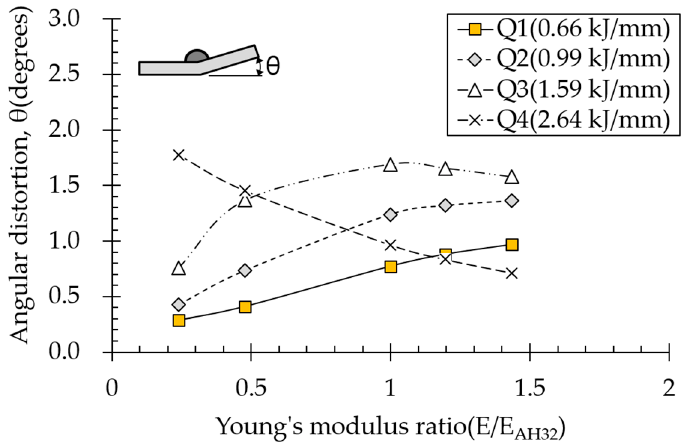
Figure 15. E ff ect of Young’s modulus on angular distortion. Figure 15. Effect of Young’s modulus on angular distortion. Figure 15. Effect of Young’s modulus on angular distortion.